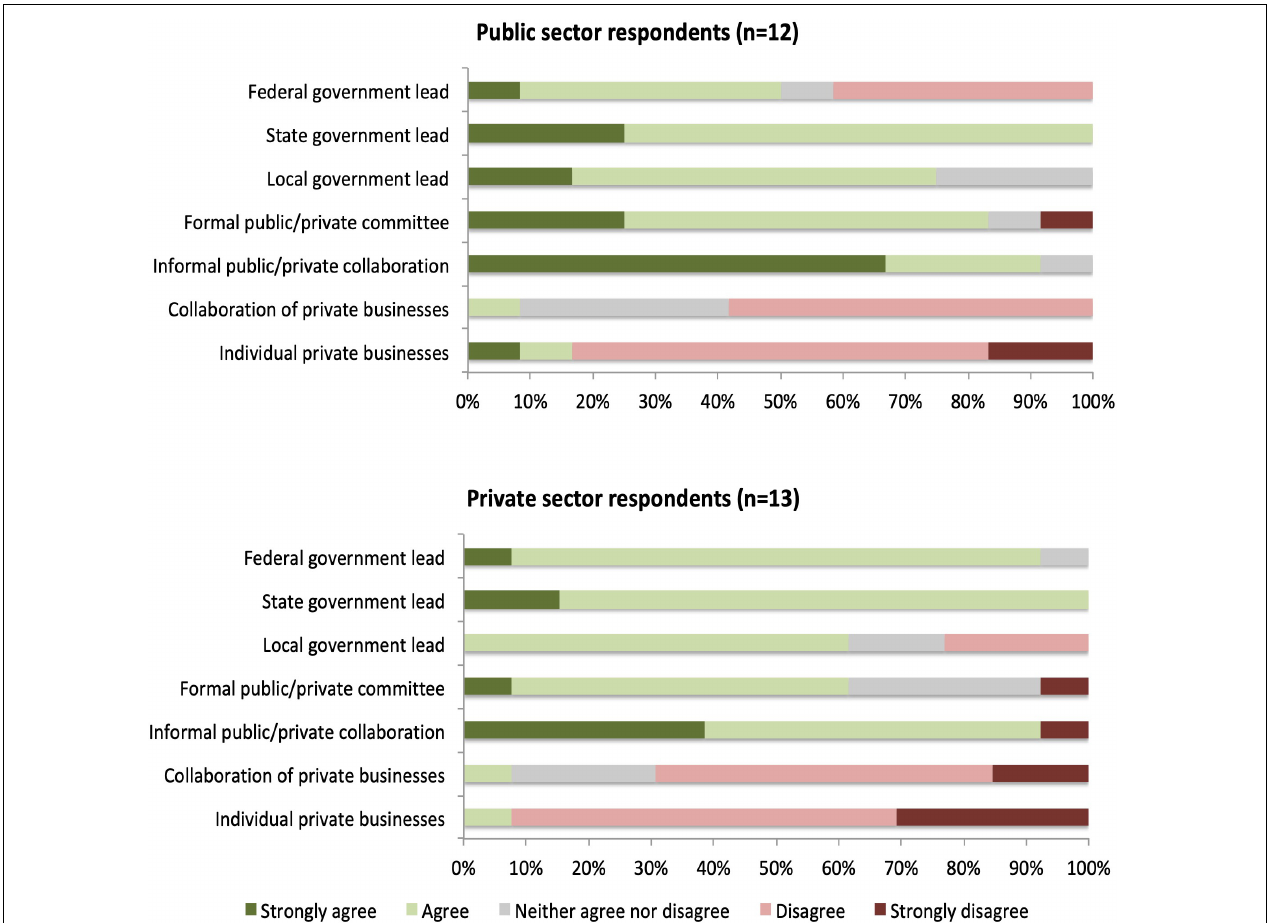
FIGURE 4 | Respondents’ opinions of what structural organization should take the lead on planning and implementing resilience